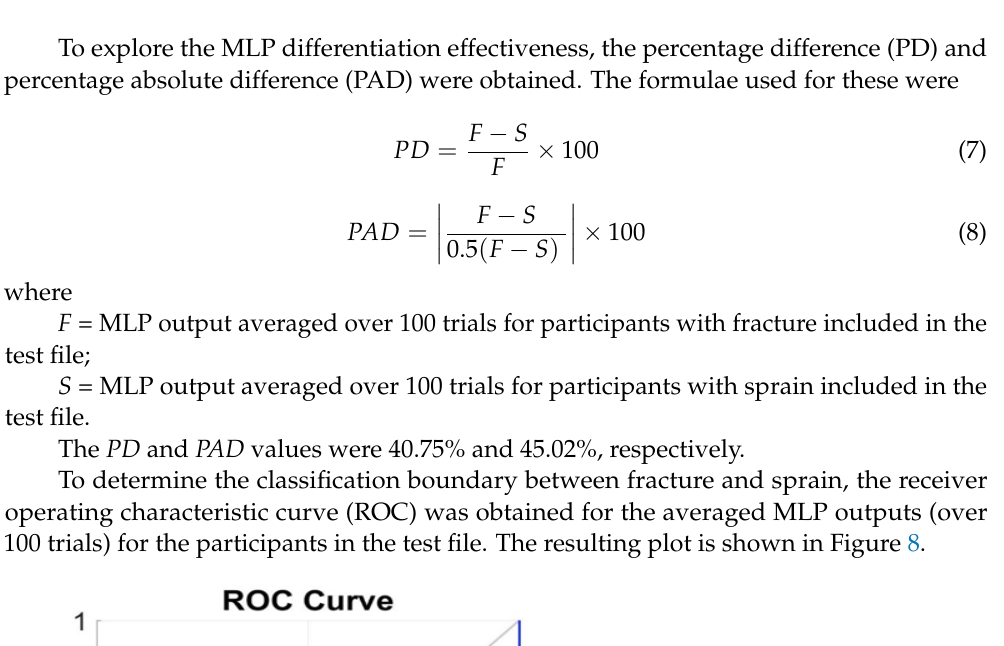
Table 2. Investigation A—averaged multilayer perceptron outputs for participants in the test file (averaged over 100 trials). The values have no units. Injury Types Average Standard Deviation Fracture 0.589 0.264 Sprain 0.349 0.247